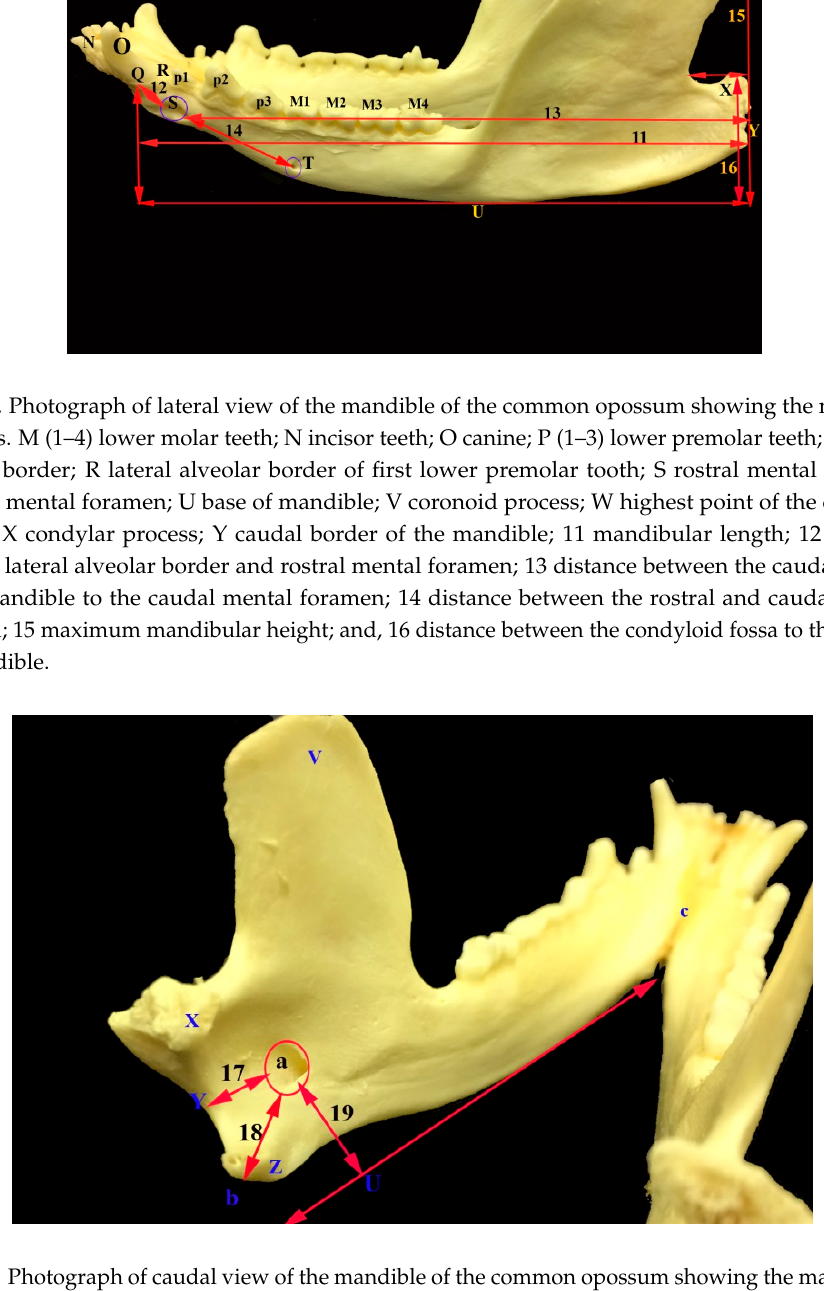
Figure 6. Photograph of caudal view of the mandible of the common opossum showing the mandibular foramen and its anatomical landmark parameters. V coronoid process; X condylar process; Z angular process; U base of the mandible; Y caudal border of the mandibular foramen; a mandibular foramen; b mandibular angle; and, c mandibular symphysis.